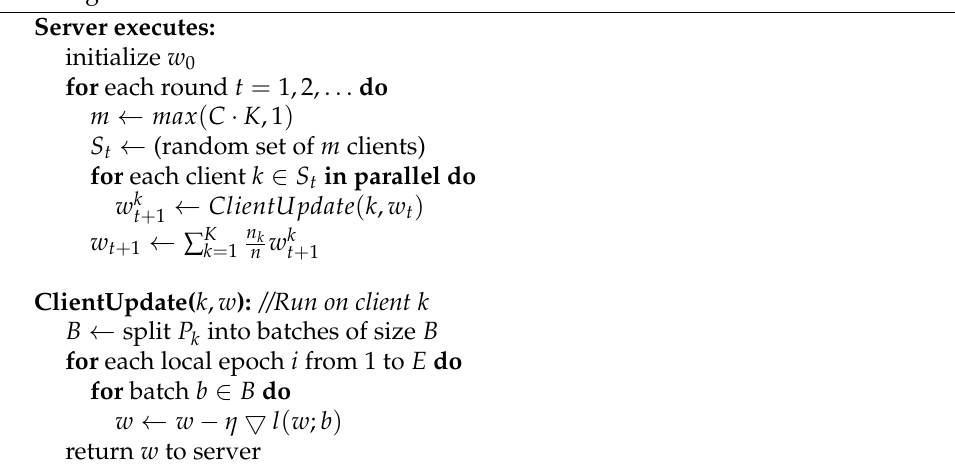
Algorithm 1: FederatedAveraging (FedAvg) . The K clients are indexed by k ; B is the local minibatch size, E is the number of local epochs, and η is the learning